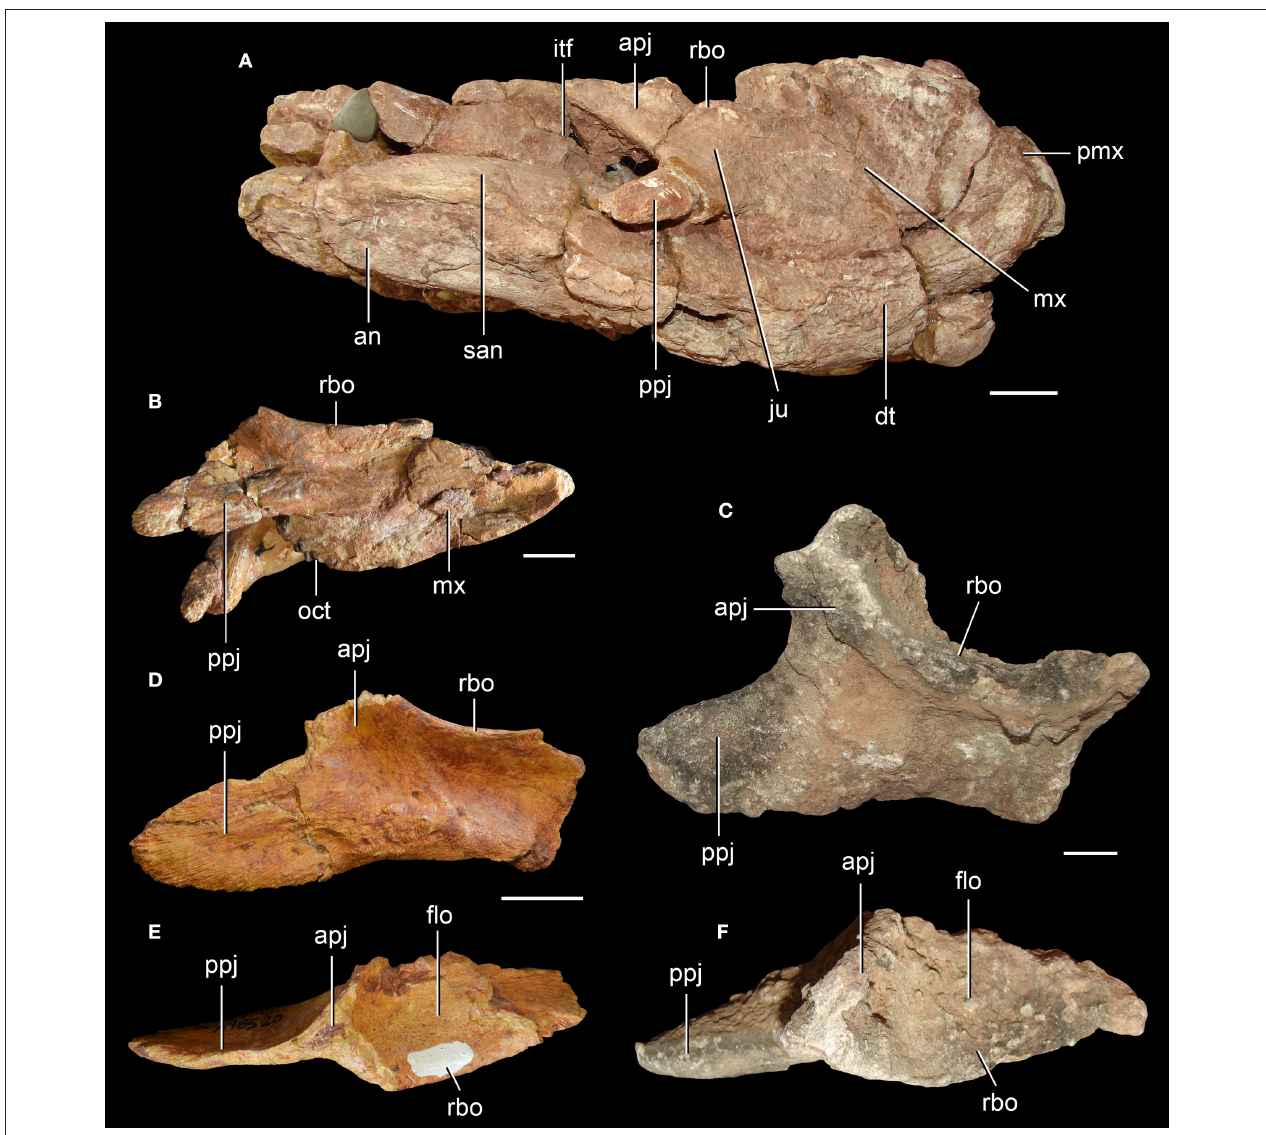
FIGURE 3 | Incomplete lower temporal bar in the Middle Triassic rhynchosaurs. S. stockleyi ( A : NHMUK PV R2270; C , F : NHMUK PV R36840) (A,C,F) and Fodonyx spenceri (EXEMS 60/1985.292, holotype) (B) , and an indeterminate rhynchosaurid from the Otter Sandstone (EXEMS 60/1985.20) (D,E) . Partial skulls in right lateral view (A,B) and isolated right jugal in lateral (C,D) , and dorsal (E,F) views. Abbreviations: an, angular; apj, ascending process of the jugal; dt, dentary; flo, floor of the orbit; itf, infratemporal fenestra; ju, jugal; mx, maxilla; oct, occlusal teeth; pmx, premaxilla; ppj, posterior process of the jugal; rbo, raised border of the orbit; san, surangular. Scale bars equal 2cm in (A) and 1cm in (B-F)